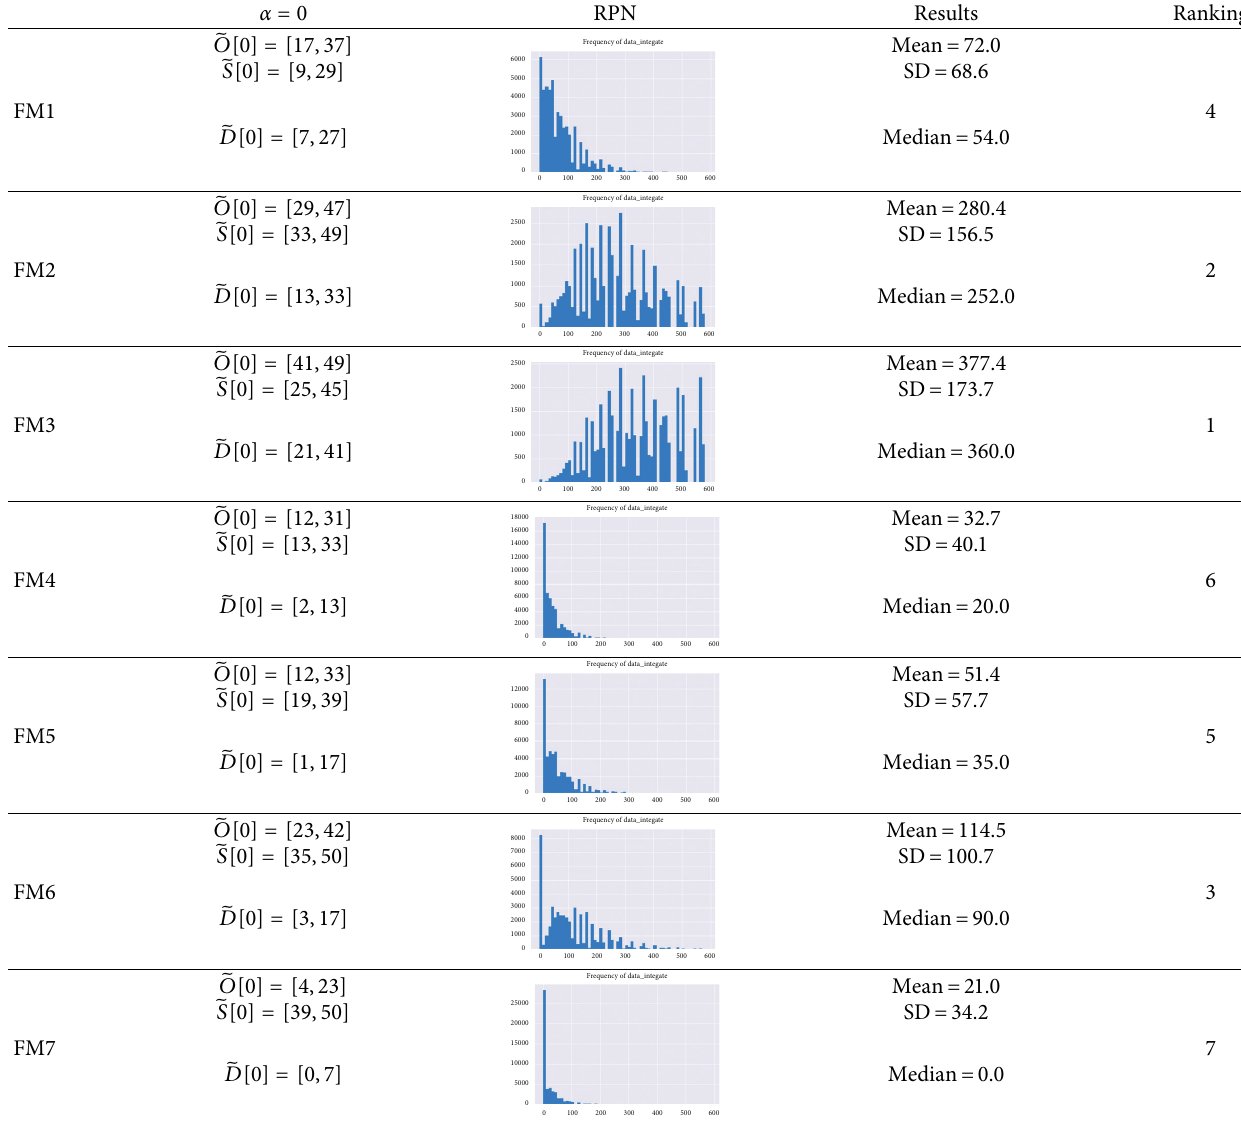
Table 8: The RPN under α �